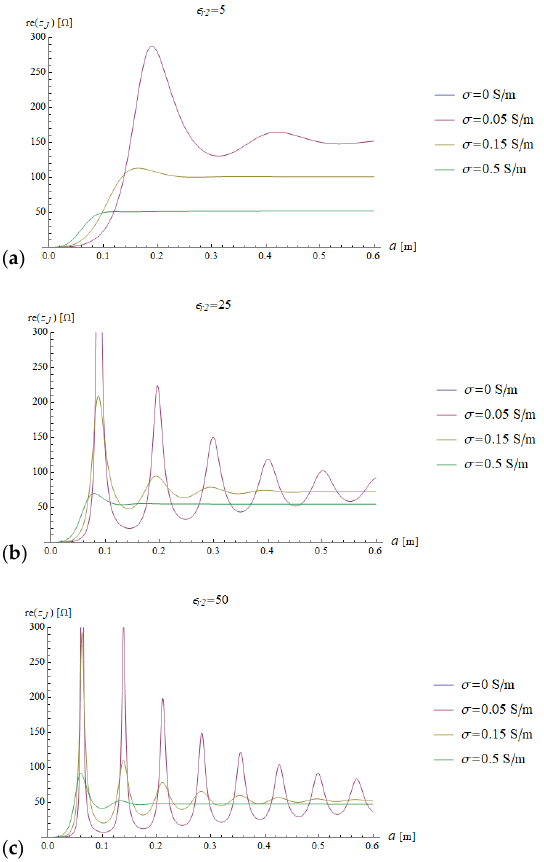
Figure 6. The real part of the sphere impedance is plotted as a function of the sphere radius for different values of relative permittivity ( 𝜀 𝑟2 = 5, 25 and 50 in ( a – c ), respectively) and a range of conductivity values.